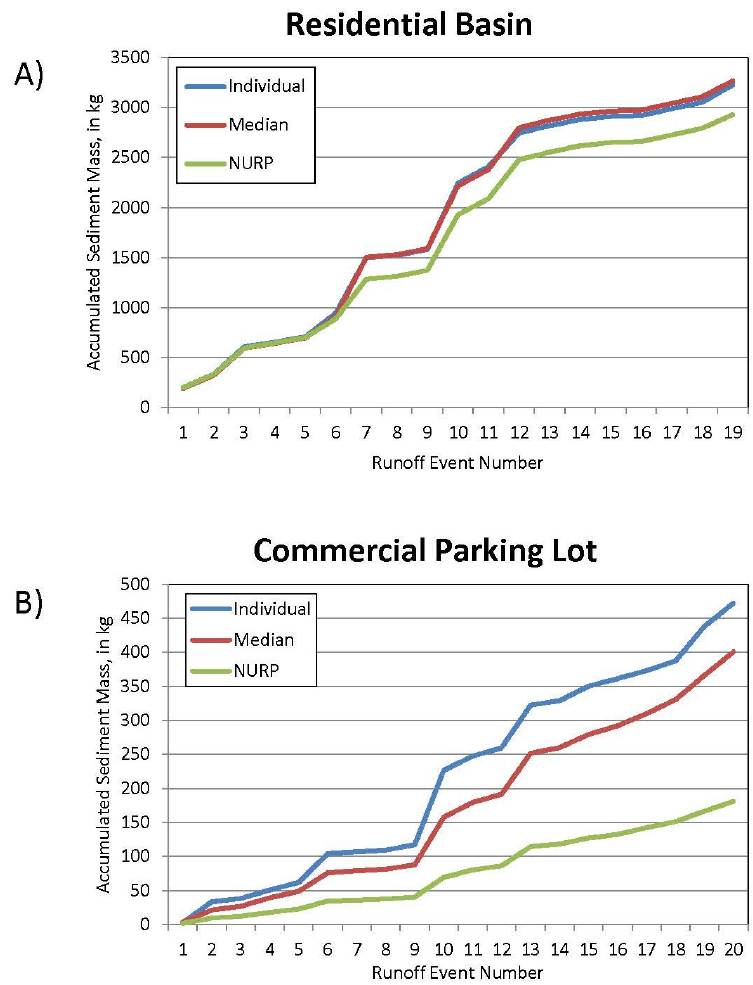
Figure 7. Accumulated sediment mass retained in a wet pond in the residential basin ( A ) and two catch basins in the commercial parking lot study area ( B ) using the individually-measured, the median of the measured and NURP PSDs.